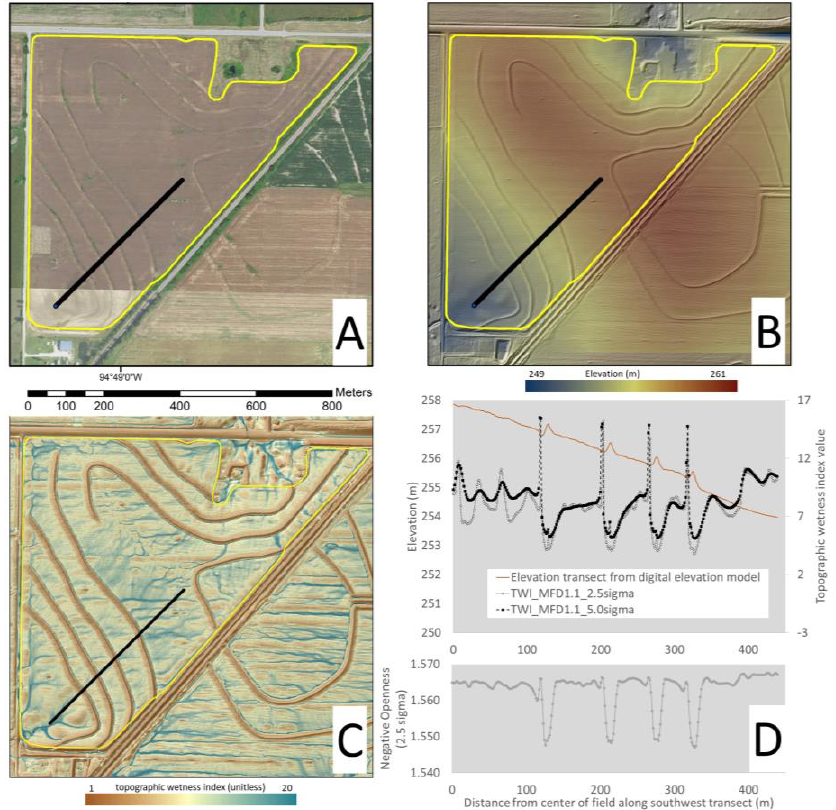
Figure 3. The black line in image ( A ) indicates an elevation transect from the highest elevation at the BN site to the area of lowest elevation. Image ( B ) shows a color ramp for elevation at the site. Image ( C ) shows an iteration of the topographic wetness index (TWI), with higher values given in blue and lower values in red. Image ( D ) shows the variation in values of selected terrain derivatives along the transect, including topographic wetness index at both levels of smoothing, and the negative openness algorithm after DEM Gaussian smoothing to 2.5